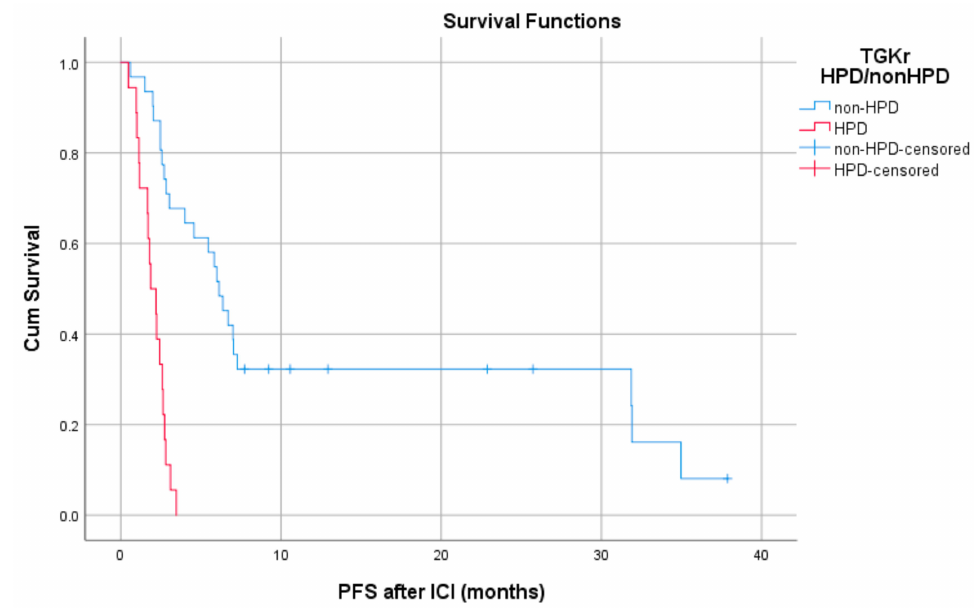
Figure 1. Association of type of progressive disease (hyperprogression (HPD) vs. non-HPD) with progression free survival (PFS) post immunotherapy initiation (ICI).